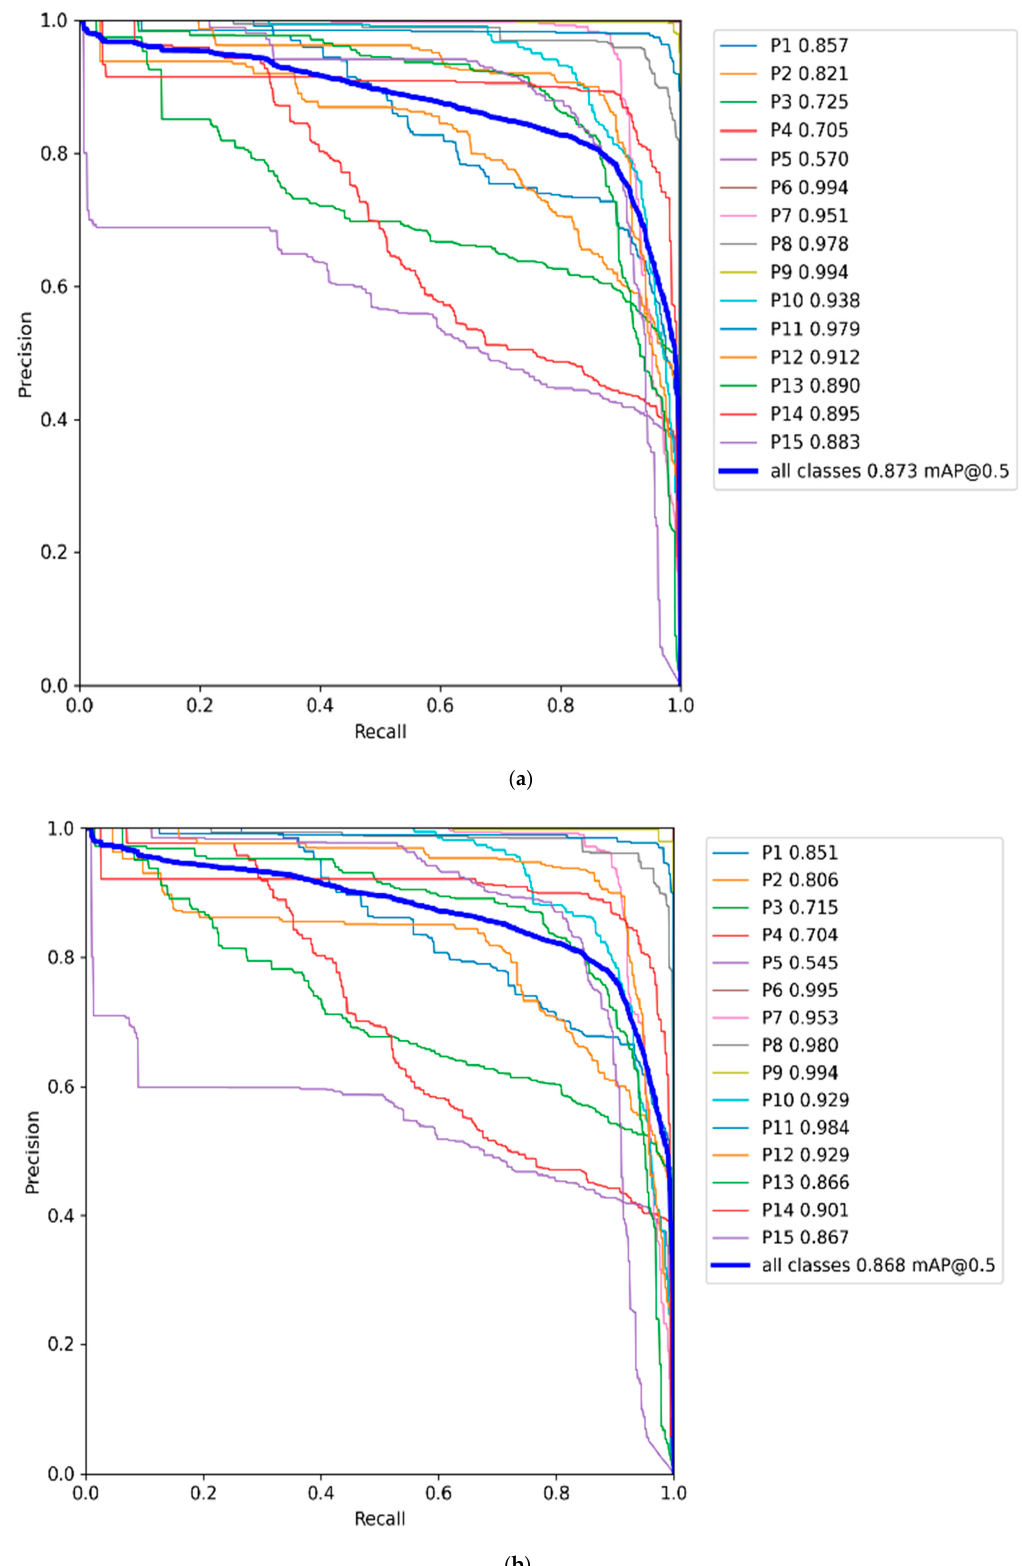
Figure 5. Precision and recall. ( a ) Yolov5m, and ( b ) Yolov5l.